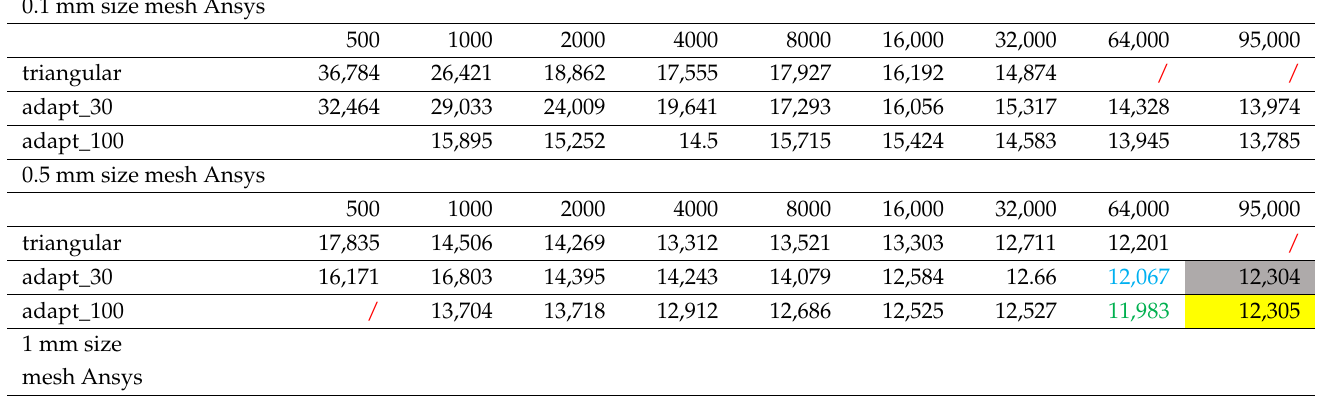
Table 5. The results expressed in MPa of the FEA analysis on traction on the different models of the laboratory specimen. The different colours highlight the values that were recurrent in the analysis even with different element dimensions.